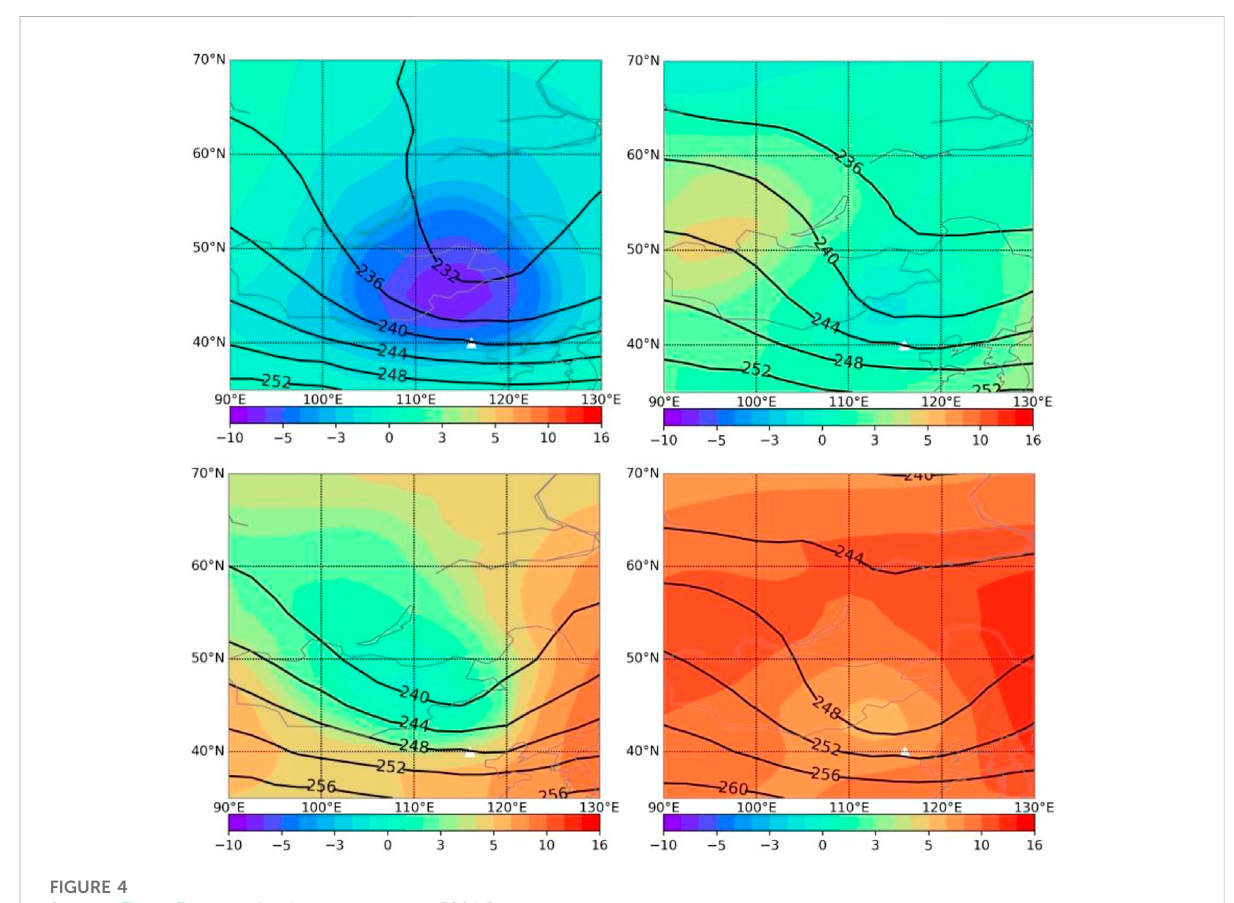
FIGURE 4 Same as Figure 3, except for the temperature at 500